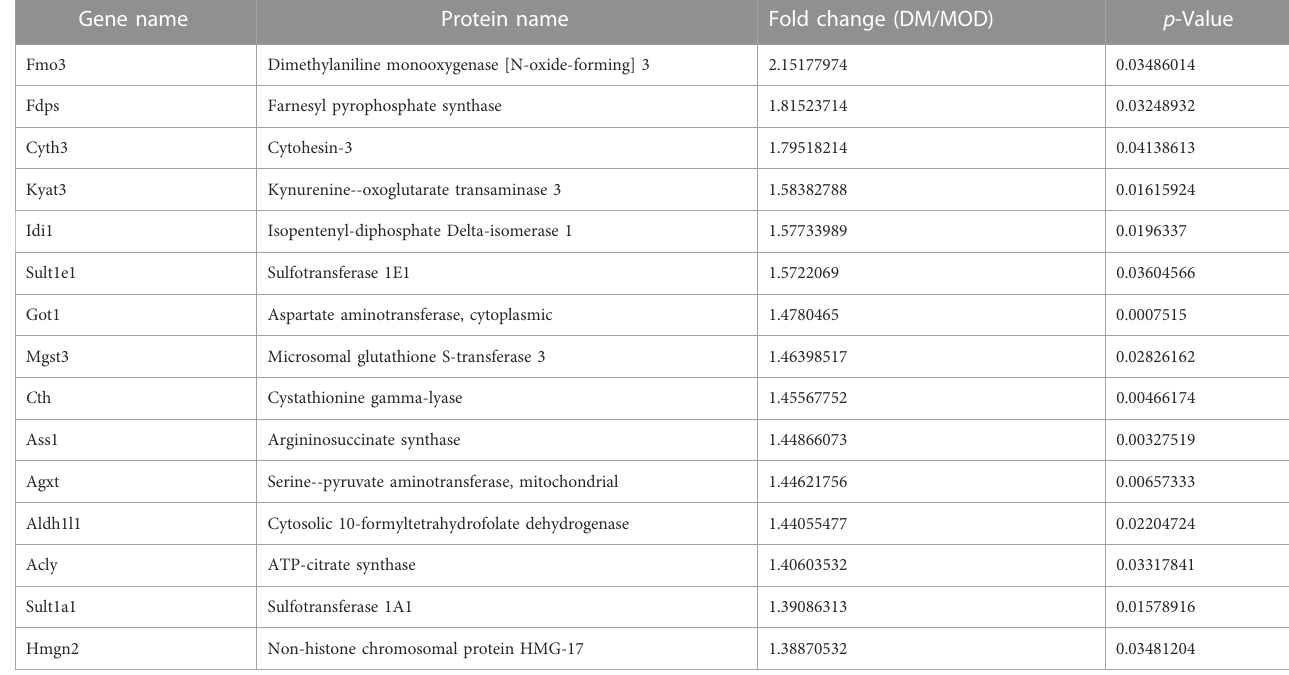
TABLE 1 Selected signi fi cantly upregulated proteins in the Dendrobium mixture (DM) group compared with the model (MOD) group.